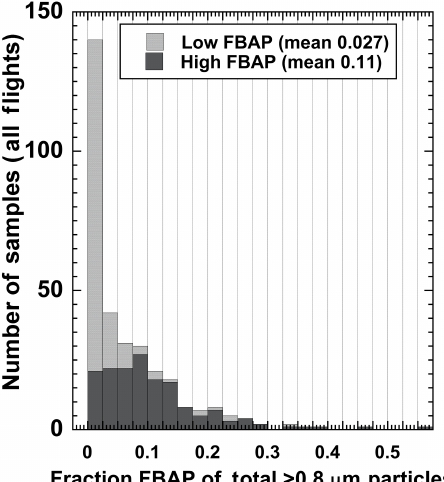
Figure 5. Vertical profiles of fluorescent biological aerosol parti- cle concentration measured by the WIBS-4A for five flights with dates and colors shown, with approximate ice nucleation tempera- ture ranges as discussed in the text highlighted. (a) Lower-bound values based on WIBS-4A categorization; (b) upper-bound values.